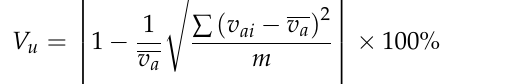
Figure 7. Streamlines distribution in the sump under different cases.